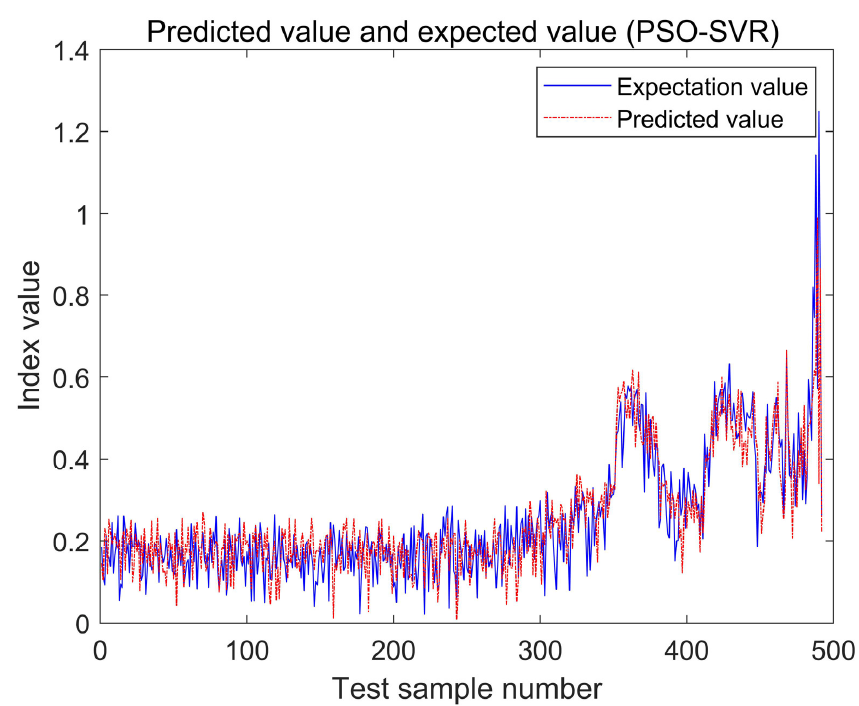
Figure 12. The regression prediction analysis of the test set by